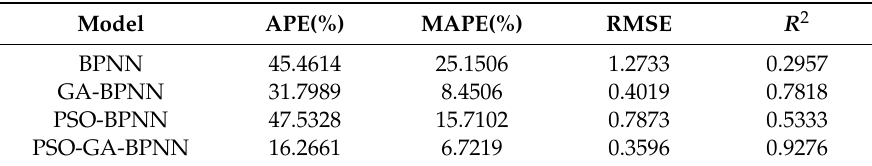
Table 3. The performance of the four